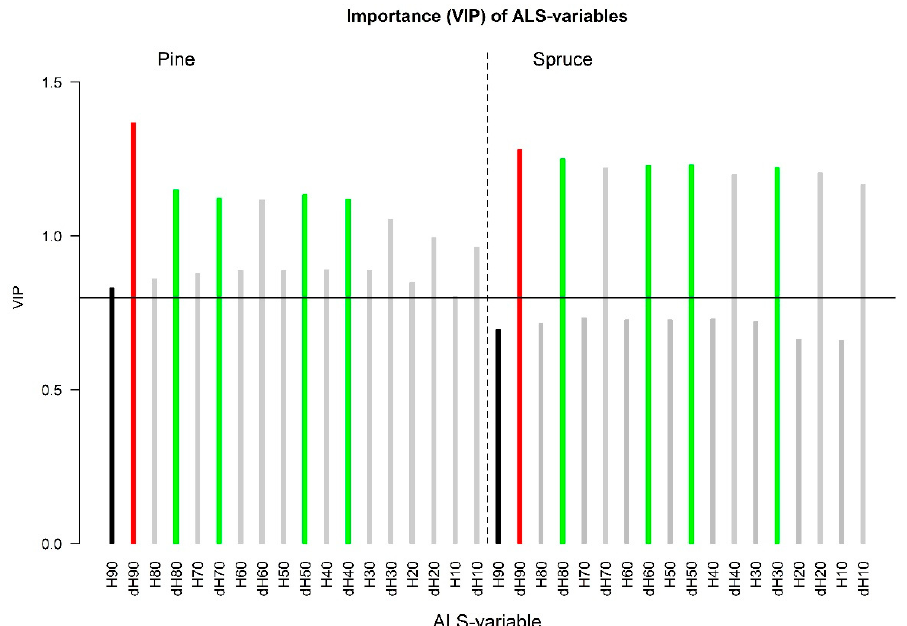
Figure 1. Variable importance for projection (VIP) values from the partial least squares (PLS) analysis with site index as a response for ALS-variables. Results for pine appear on the left, and results for spruce appear on the right. The five top-ranking variables according to VIP appear in green. Variables among the top-ranking variables that were included in the subsequent modelling appear in red. Black bars indicate variables that were selected in the modelling, but that were not among the top five.